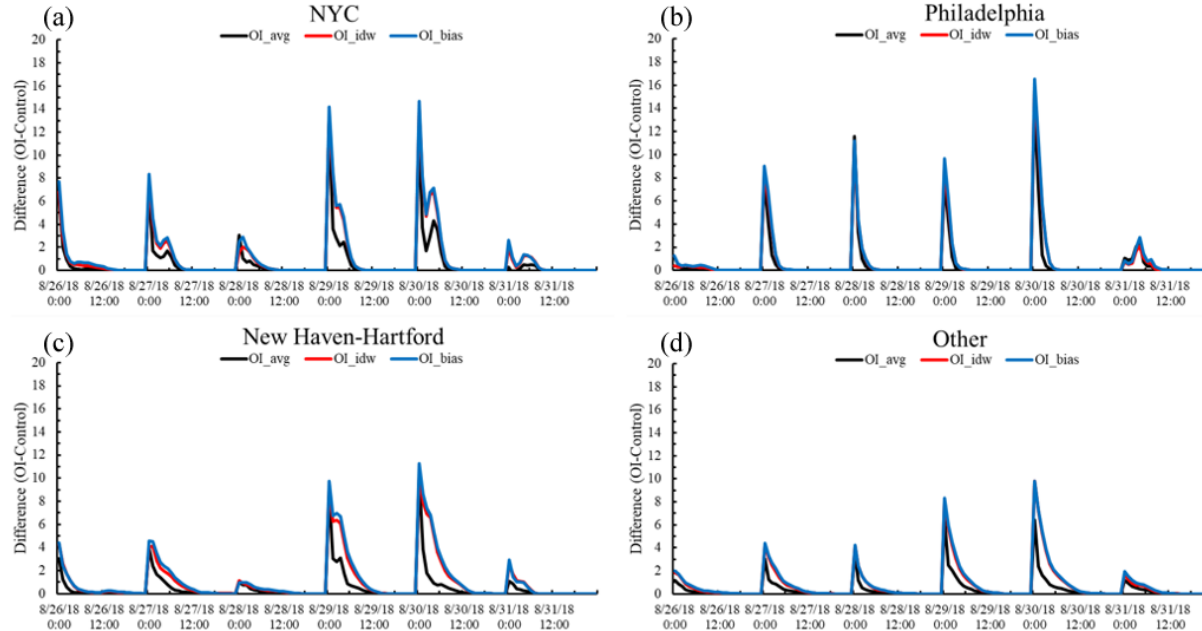
Figure 6. Effects of OI-adjusted initial concentrations on hourly surface O 3 in three metropolitan areas (New York, Philadelphia and New Haven–Hartford) and the rest of the domain using three optimal interpolation (OI) approaches (OI_avg, OI_idw and OI_bias).